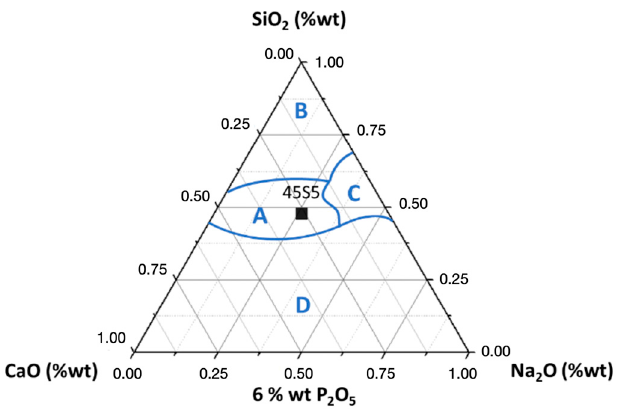
Figure 1. Hench diagram and bioactivity index in the SiO 2 -Na 2 O-CaO system and 6% P 2 O 5 . 45S5 refers to the composition of bioglass according to Hench description.